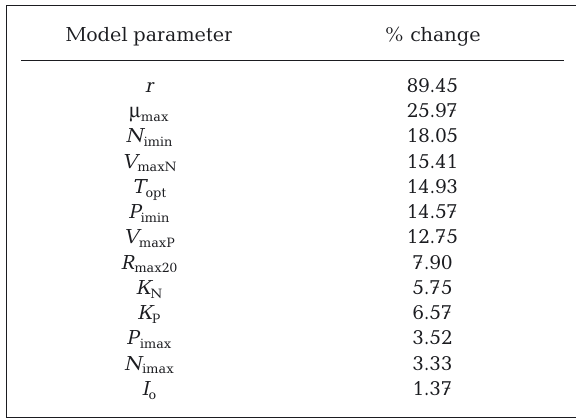
Table 1 for parameter definitions